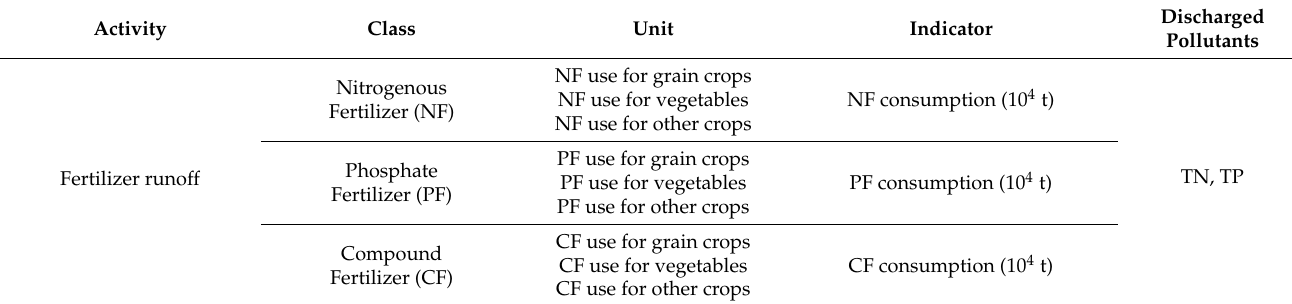
Table 3. Agricultural non-point source pollution unit